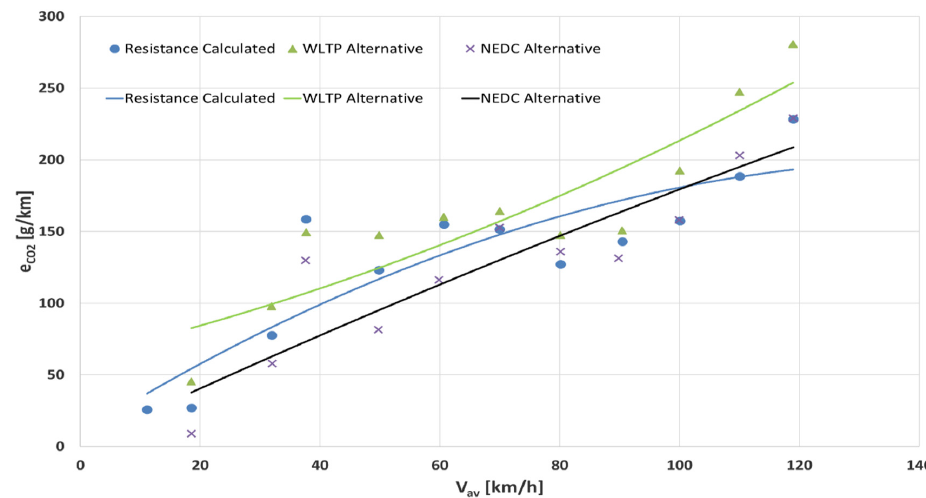
Figure 7. Comparison of the relationship between CO 2 emission rate and average speed for analysed dynamometer load settings.